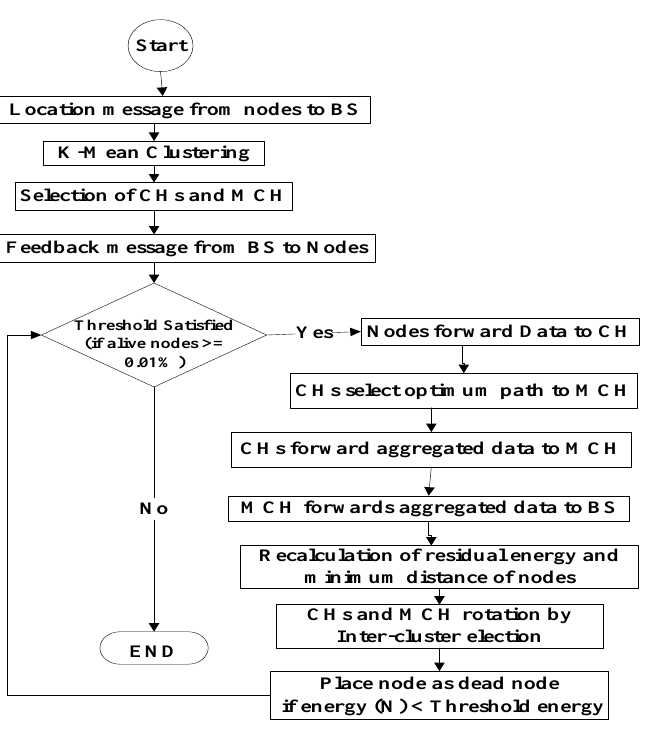
Figure 2. The flow of the PECR algorithm.